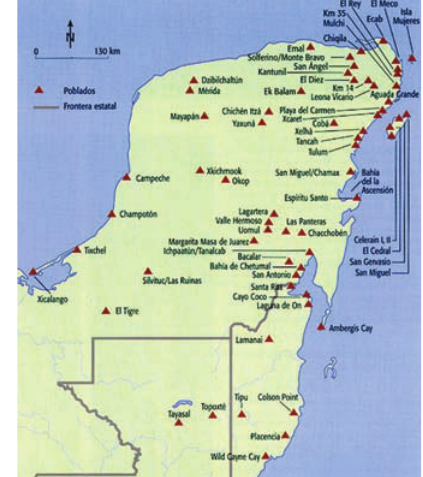
Figure 2 Postclassic period sites in the Maya area are concentrated in the northern lowlands of Belize and